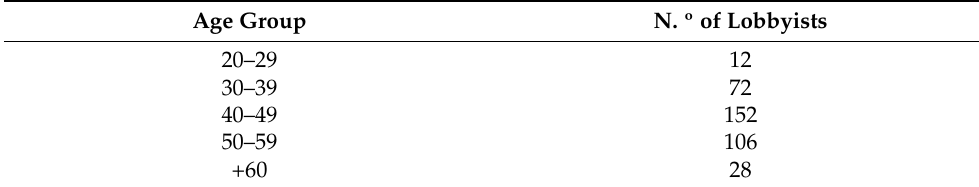
Table 2. Distribution of the age of lobbyists by age